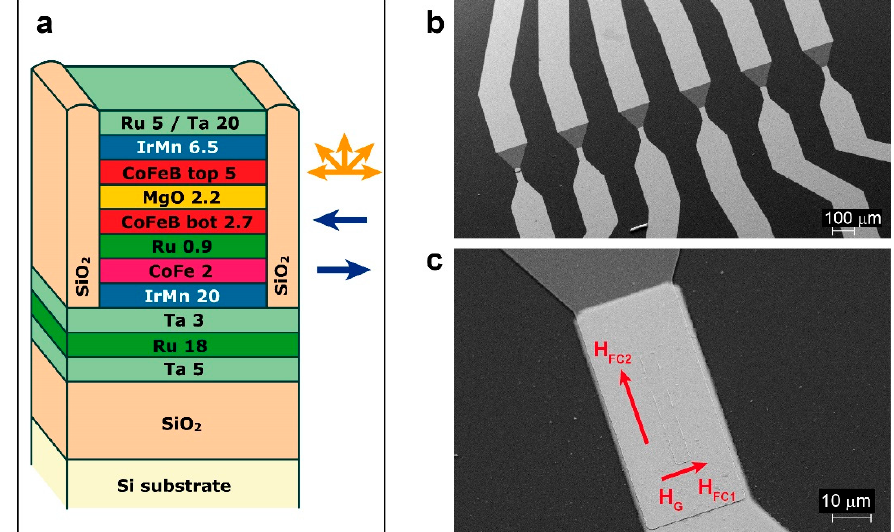
Figure 1. ( a ) Sketch of the sensor stack deposited by magnetron sputtering; ( b ) SEM image of the chip layout after optical lithography and ion milling; ( c ) SEM image of a single sensor. The red arrows mark the direction of the magnetic field applied during the first (H FC1 ) and second (H FC2 ) field cooling.